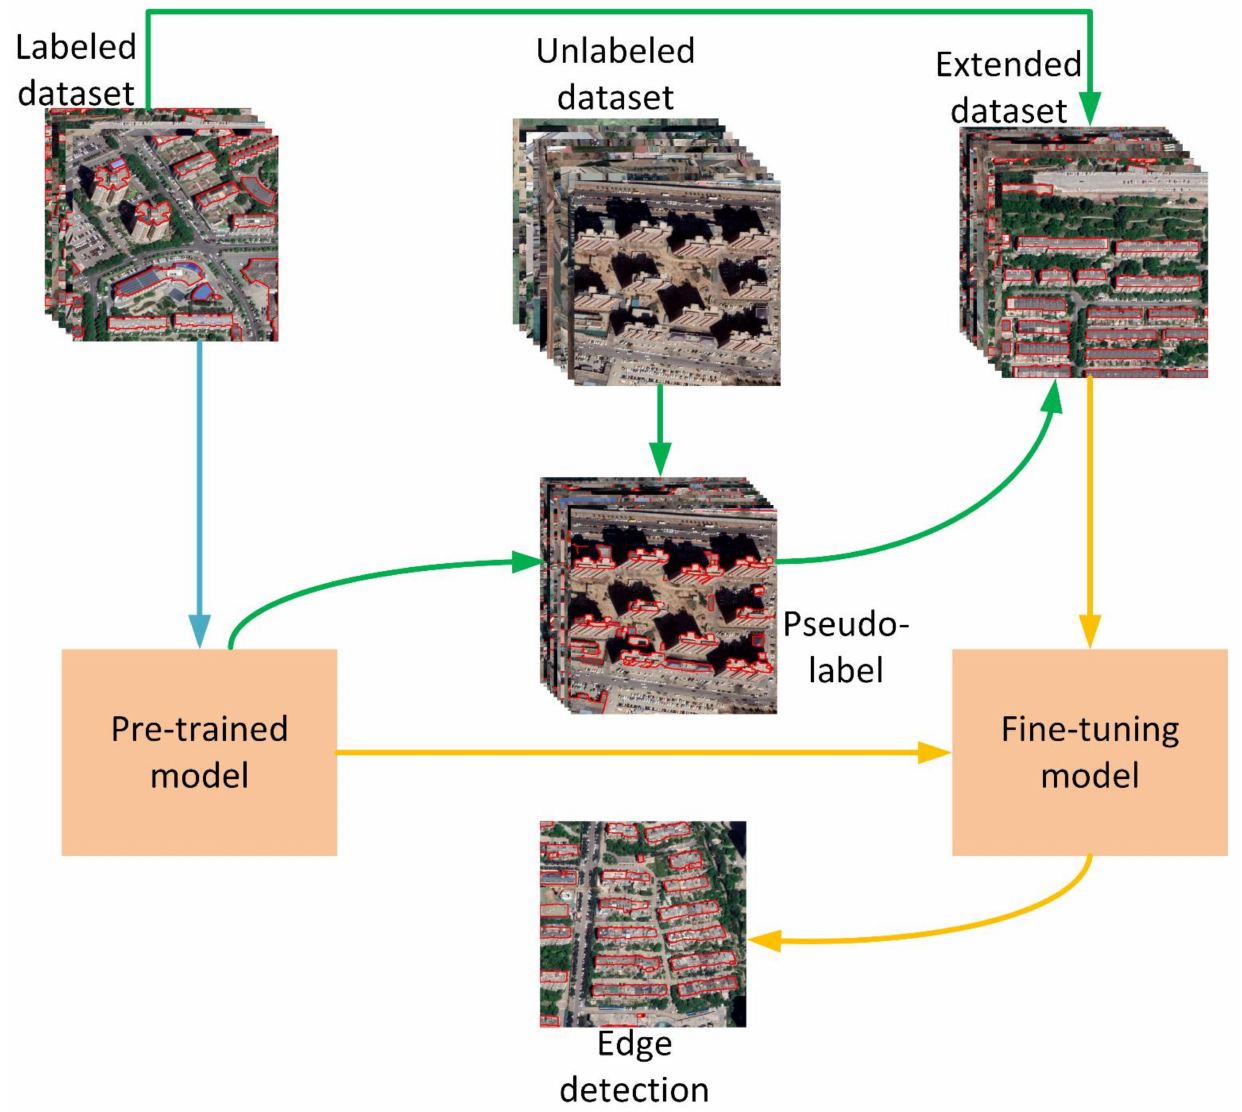
Figure 1. Edge-detection-based semi-supervised framework. A labeled dataset is used to train a pre-trained model, which predicts an unlabeled dataset to get pseudo-labels. The labeled dataset and pseudo-labels are combined to form an extended dataset, which has abundant labeled images. A fine-tuning model is trained with the extended dataset based on pre-trained